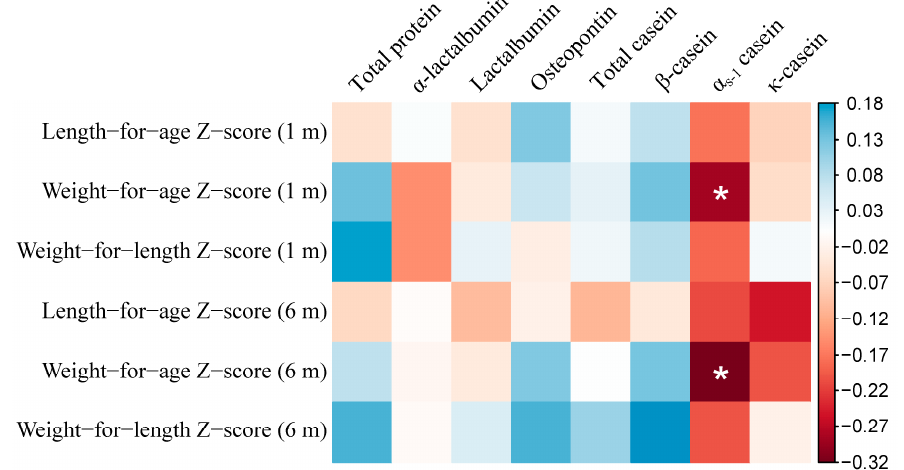
Figure 2. Correlation between human milk proteins and the growth of infants. * p < 0.05. The color in the square represents the value of the correlation coefficient. The concentrations of total protein and α -lactalbumin in the milk samples from all the participants were measured, while the concentrations of other indices were only tested for 51 participants in the subgroup. Correlation coefficients and p values were estimated via Pearson correlation. The values of lactoferrin concentration were transformed to log scale before analysis. The cumulative average concentrations of milk proteins before anthropometric measurements were calculated to represent long-term exposure, e.g., when estimating the correlation between α -lactalbumin and the length of the infant at one month postpartum, the average concentrations of α -lactalbumin measured at 1–5 and 8–14 days postpartum were calculated, and, subsequently, used in the analysis.